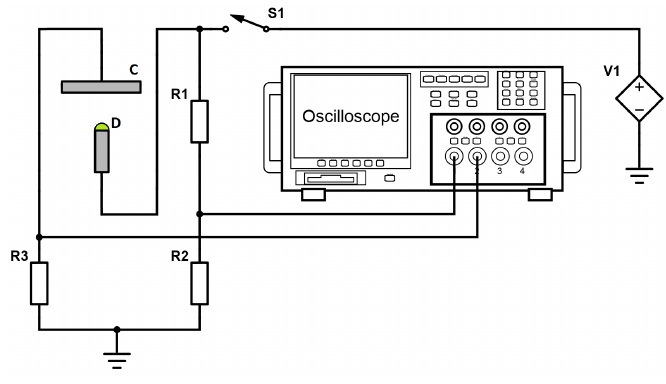
Figure 4. Schematics of the measuring device. V1—high-voltage direct-current power supply, S1—switch, D—droplet of polymer solution placed on a rod or needle metal electrode, C—collector electrode, R1—resistor (15 G Ω ), R2—resistor (1.1 M Ω ), R3—resistor (10 k Ω ). The schematics were made with Scheme-it